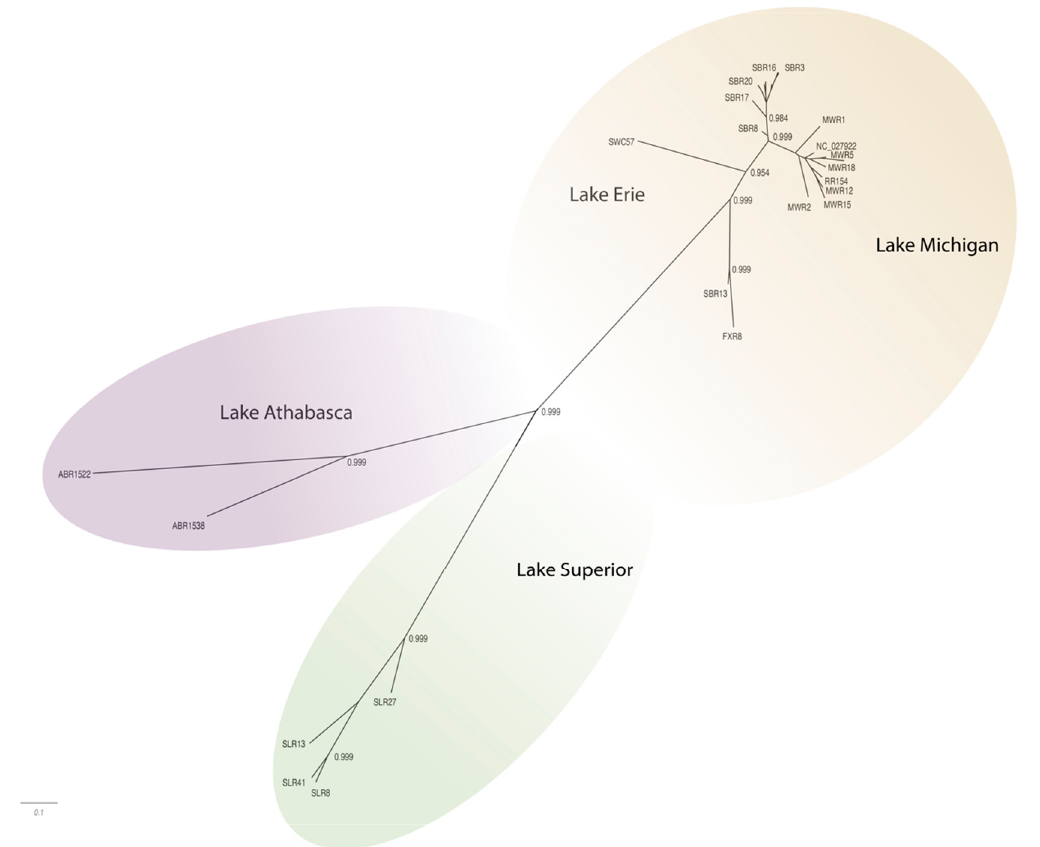
Figure 3. Radial phylogram depicting the relationships of 27 complete genomes (3541–3543 nt) of WSHBV isolated from white suckers inhabiting tributaries of the Great Lakes or the Athabasca River in Alberta Canada. Results are from Baysian analysis. Branches are labeled with posterior probability and color-coded by dominant clades. Isolates were tributaries of Athabasca Lake (Athabasca River, ABR) Lake Superior (St. Louis River, SLR); Lake Erie (Swan Creek, SWC) and Lake Michigan (Fox River, FXR; Milwaukee River, MWR; Sheboygan River, SBR and Root River, RR).